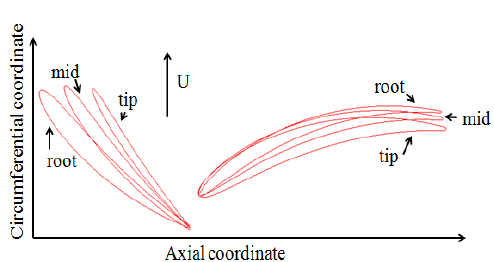
Figure 2. Blade sections at three spanwise locations.